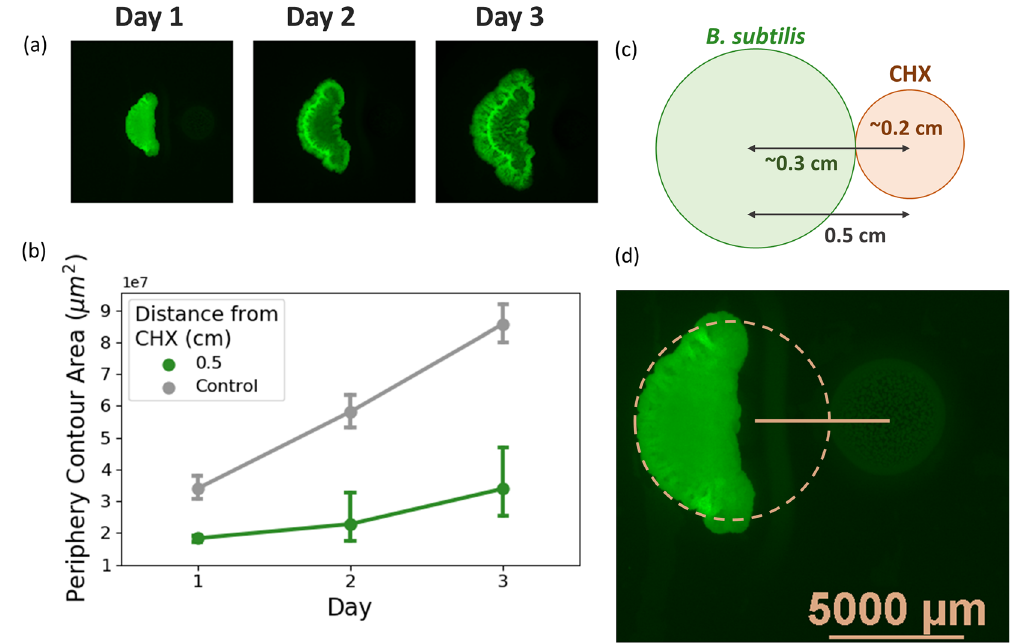
Figure 6. Crescent-shaped morphology occurring at CHX distances of 0.5 cm. ( a ) Top row illustrates the macrocolony morphology over a period of 3 days—the change in morphology appears in the form of “crescent- shaped” colonies. ( b ) Expansion comparison with control macrocolonies. ( c ) Illustration depicting several relevant distances when CHX is placed at 0.5 cm-average radius of a mature B. subtilis macrocolony on day 1, average radius of a CHX droplet. ( d ) Representative image of macrocolony on day 1, with CHX (color corrected for visual clarity) shown to the right.